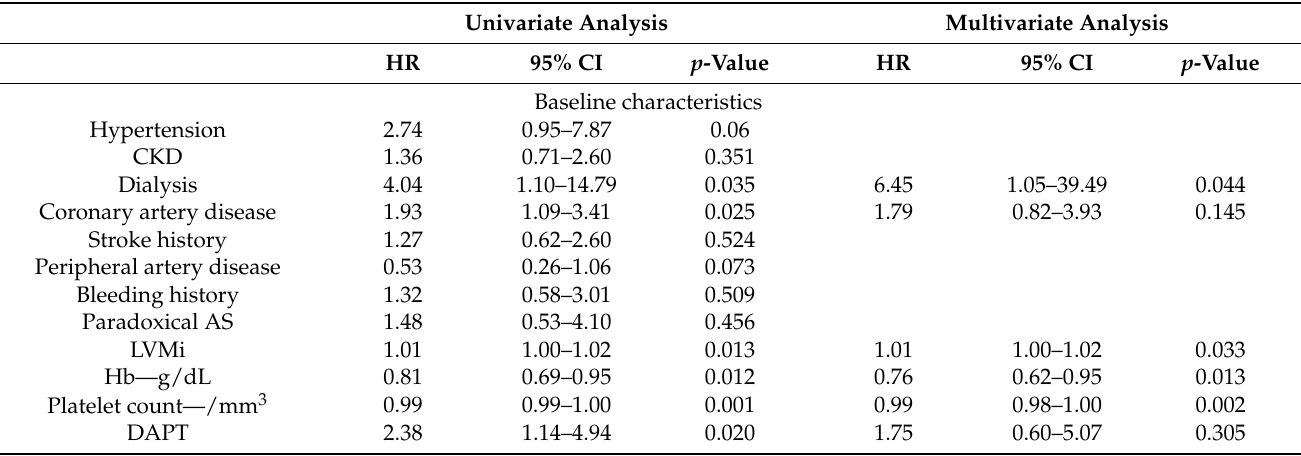
Table 5. Predictors of post-procedural CT-ADP > 180